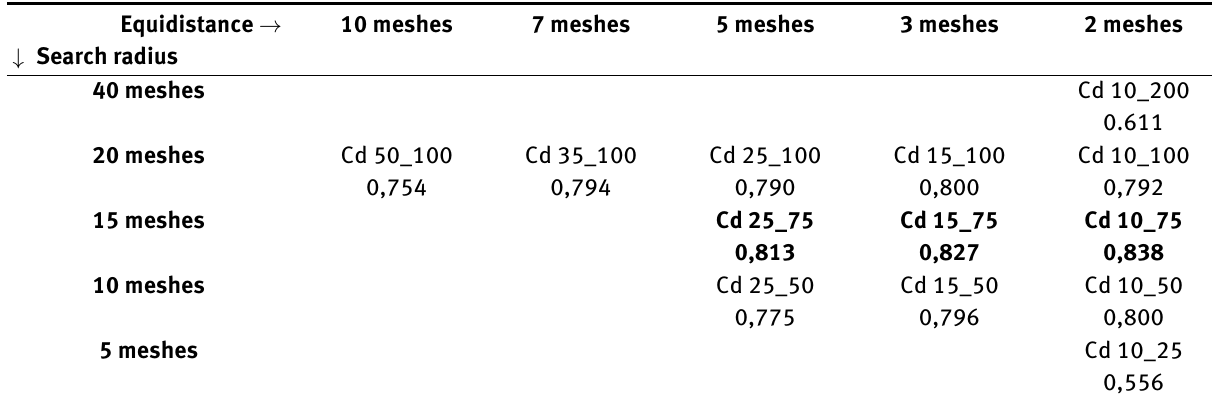
Table 1: Correlations between perceived traflc time ratio and traflc densities. The nomenclature of density maps (Cd) is as follow: Cd (equidistance between points in meters) _ (search radius in meters). The equidistance and the search radius correspond to several num- bers of meshes. The data for a search radius of 75 m are in bold.